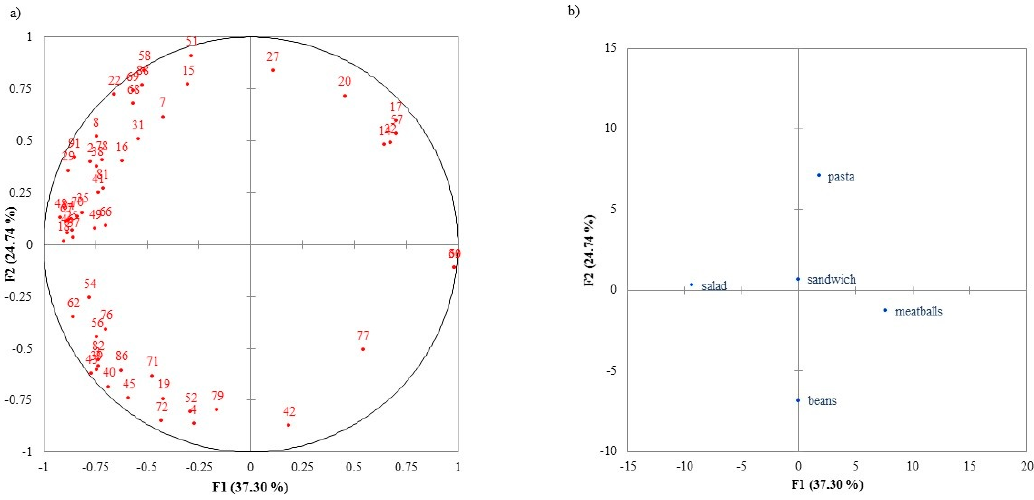
Figure 4. Internal preference map of consumer actual liking scores in Tasting+Pack condition: ( a ) consumers, ( b ) samples.